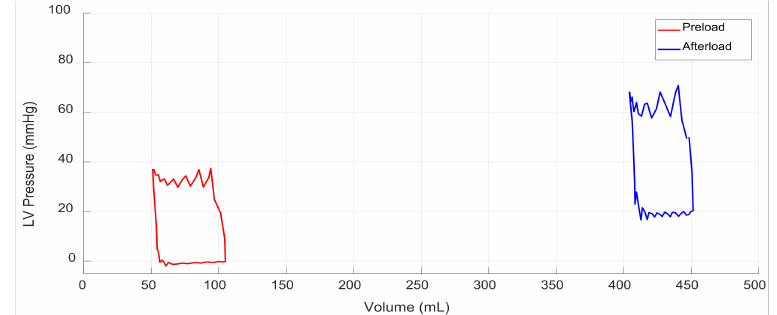
Figure 7. Hemodynamic characteristic of preload and afterload in severe HF